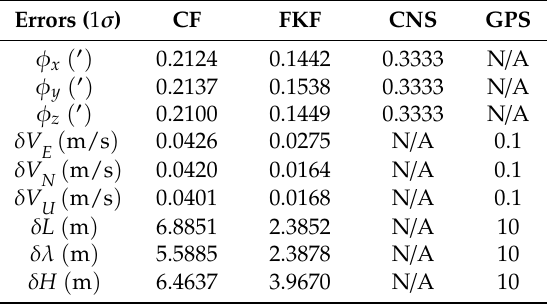
Table 2. Comparison of estimation errors between CF and federated Kalman filter (FKF). Errors ( 1 σ ) CF